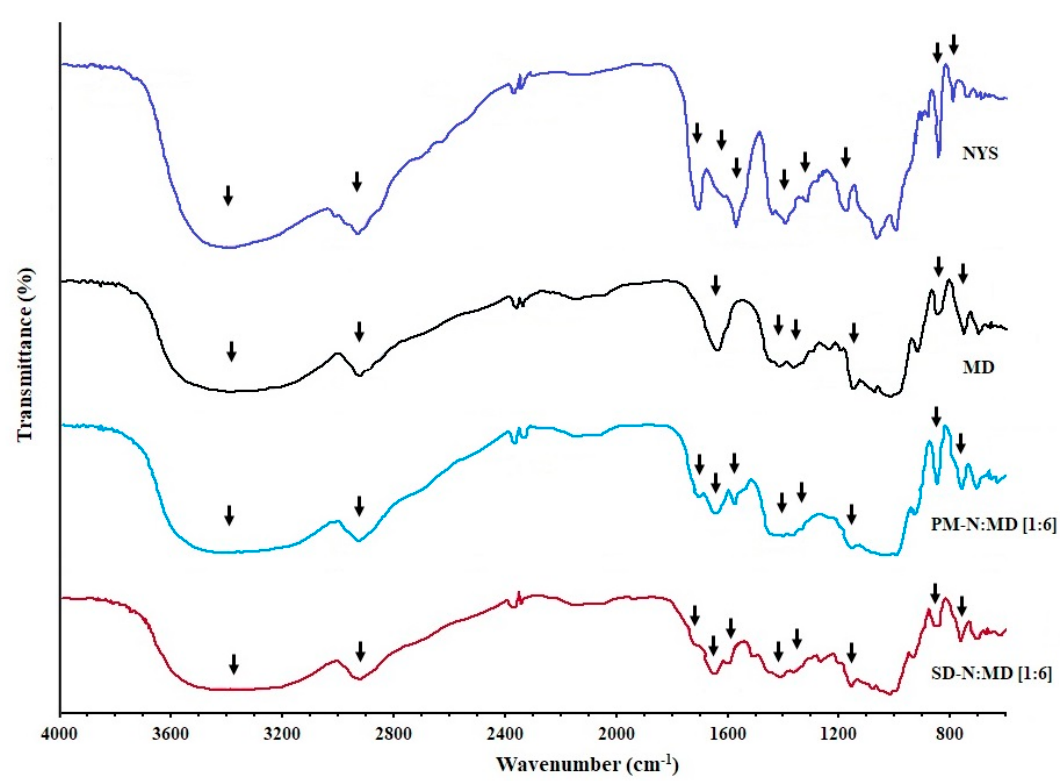
Figure 2. FTIR spectrum of nystatin raw material (NYS), maltodextrin (MD), PM-N:MD [1:6] physical mixture, and SD-N:MD [1:6] solid dispersion.